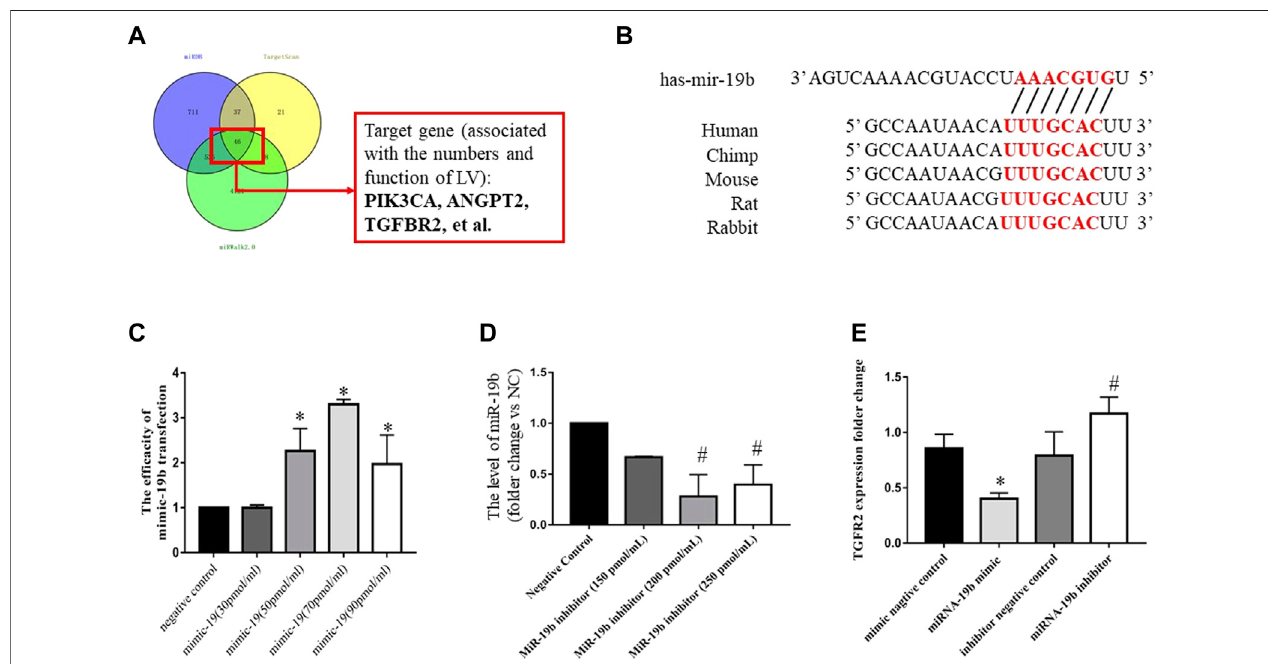
FIGURE 7 | Regulatory effects of miR-19b on TGF β RII expression in LECs. (A) Schematic of miRNA-19b target prediction. (B) Schematic representation of the 3 ′ untranslated region of TGF β RII mRNA with the predicted target sites for miR-19b as well as miR-19b inhibitor (miR-19b inhibitor group) and a corresponding negative control (inhibitor negative control group). (C) LECs were transfected with miR-19b mimic at different concentrations or a negative control fragment, and miR-19b expression was measured by RT-PCR and normalized to RNU6B expression. * p < 0.05 compared with the respective control group. (D) LECs were transfected withmiR-19binhibitoratdifferentconcentrationsandacorrespondingnegativecontrolfragment,andmiR-19bexpressionwasmeasuredbyRT-PCRandnormalizedto RNU6B expression. # p < 0.05 compared with negative control. (E) LECs were transfected with miR-19b mimic (miR-19b mimic group) or a negative control fragment (negativecontrolgroup) aswellasmiR-19b inhibitor (miR-19b inhibitorgroup) oracorrespondingnegative control (inhibitornegativecontrolgroup), andTGF β RIImRNA expression was measured in the different groups. * p < 0.05, # p < 0.05 compared with the respective control group.